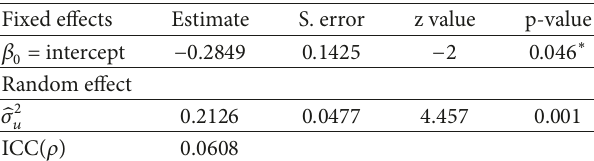
Table 2: Estimates for variance components model (EDHS,